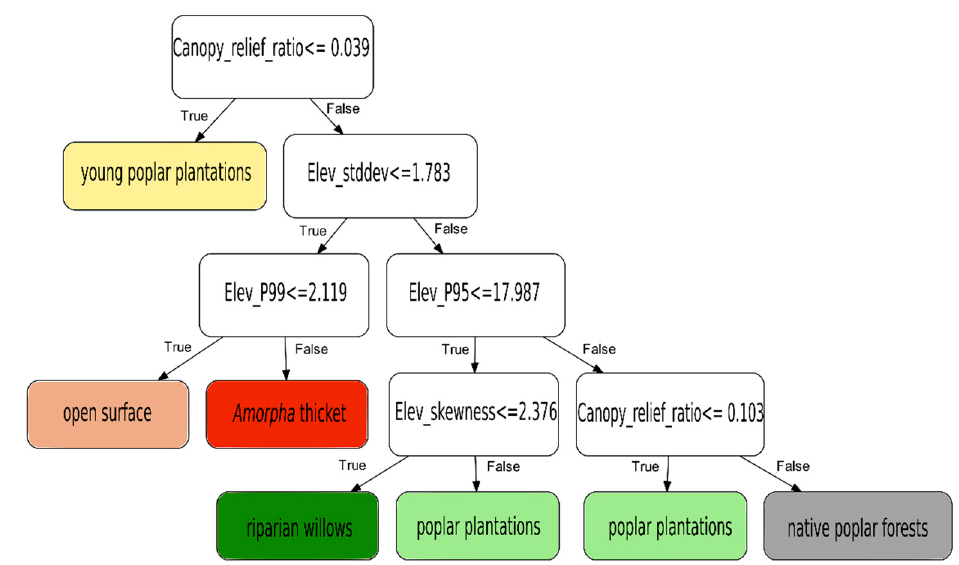
Figure 3. Decision tree created based on selected study plots within the study area. Table 2. Main characteristics of the identified riparian vegetation types. Vegetation Type